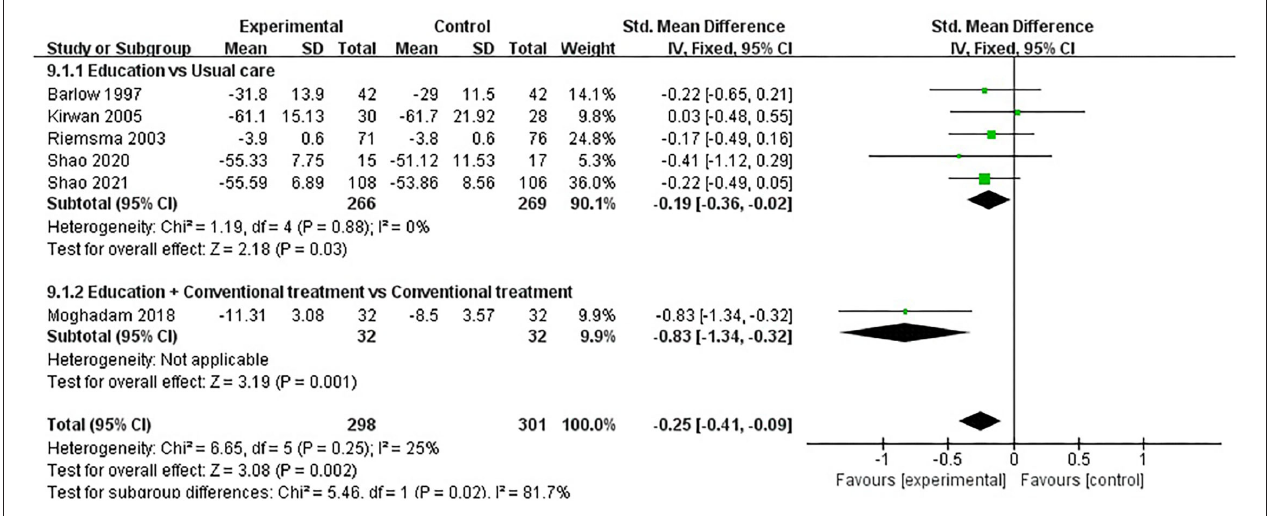
FIGURE 10 | Meta-analysis on ASE (other symptoms).